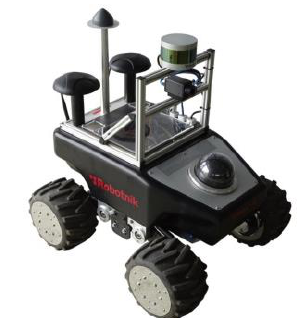
Figure 2: UGV Robotnik Summit XL carrying ANKommEn payload